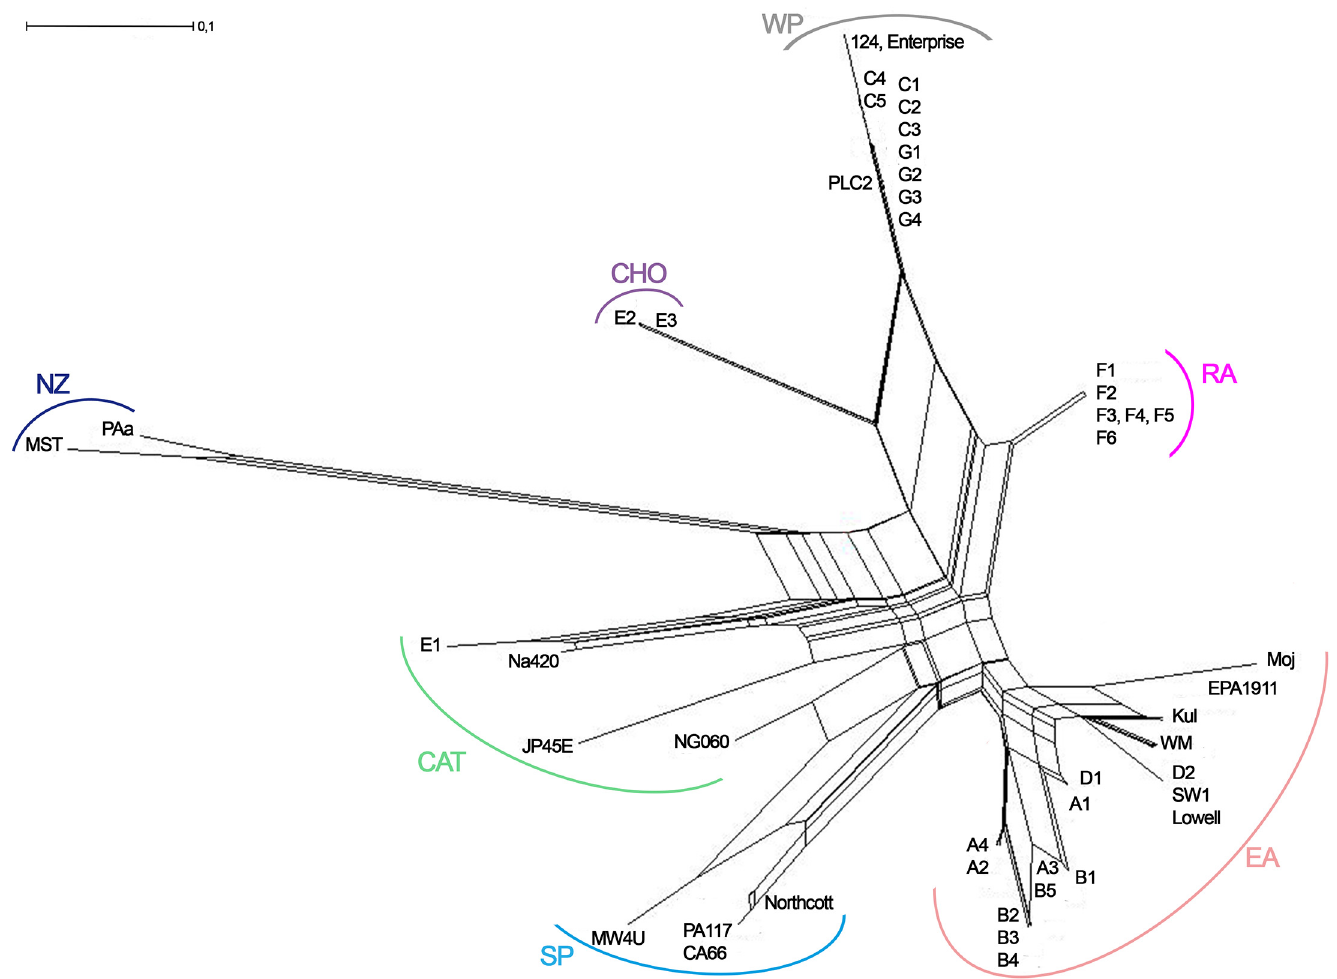
Fig 2. The NeighborNet network of the seven genetic groups of N . fowleri identified by the microsatellite markers. The strains labelled in blue, orange, pink, green, grey, purple and black correspond to those that were assigned to the SP, EA, RA, CAT, WP, CHO and NZ respectively.